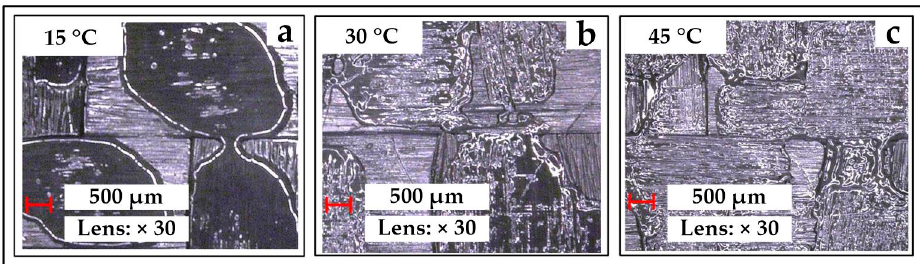
Figure 4. The resin conditions at three temperatures with magnification of the microscope is 30: ( a ) the condition at 15 ◦ C; ( b ) the condition at 30 ◦ C; ( c ) the condition at 45 ◦